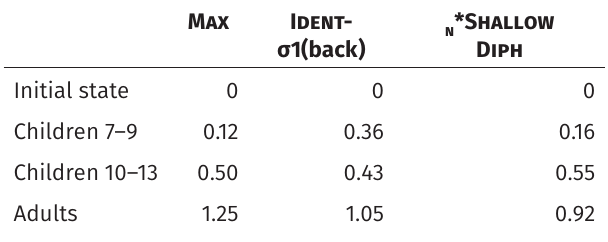
Table 10: The plural acquisition path as gradual constraint weight